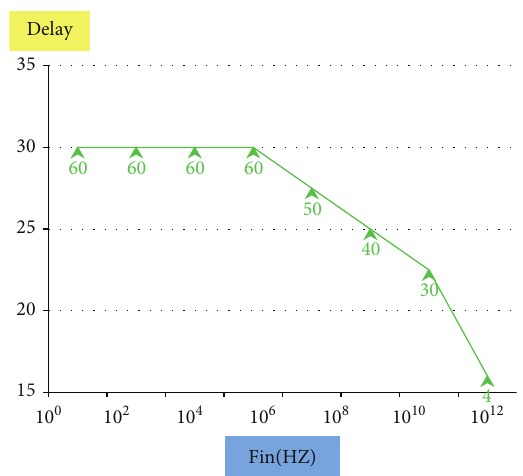
Figure 9: The relationship between RC delay and the frequency of the input signal.